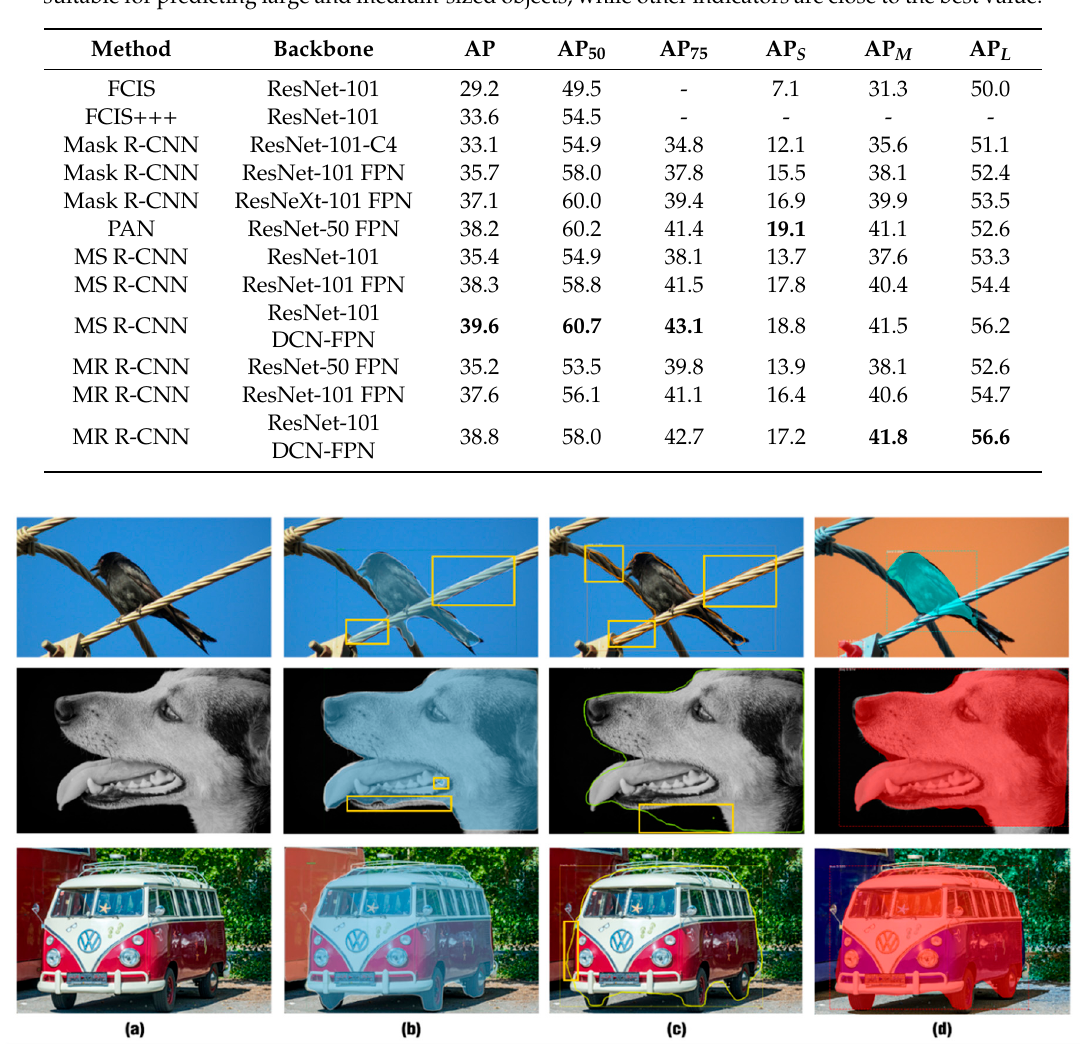
Figure 4. Comparison between MR R-CNN and state-of-the-art methods. ( a ) Original images, ( b ) PAN, ( c ) MS R-CNN and ( d ) MR R-CNN. Our approach performs better in most large instances.